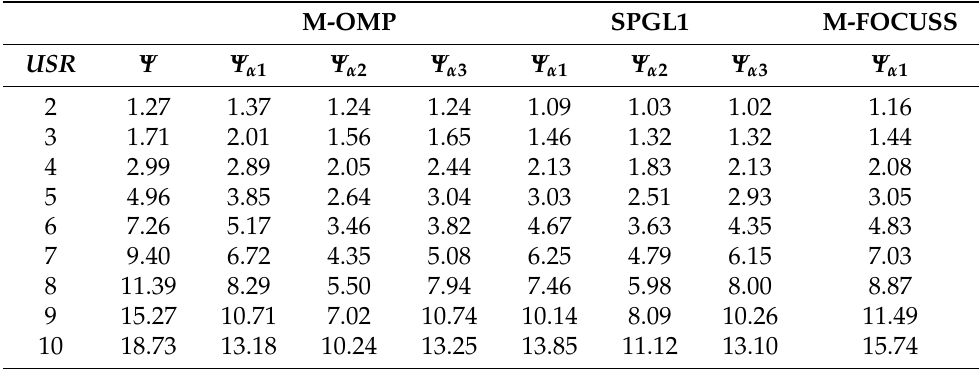
Table 6. Comparison of PRD values from the algorithms using the three dictionary matrices at several USR values, for ECG signal No. 122.